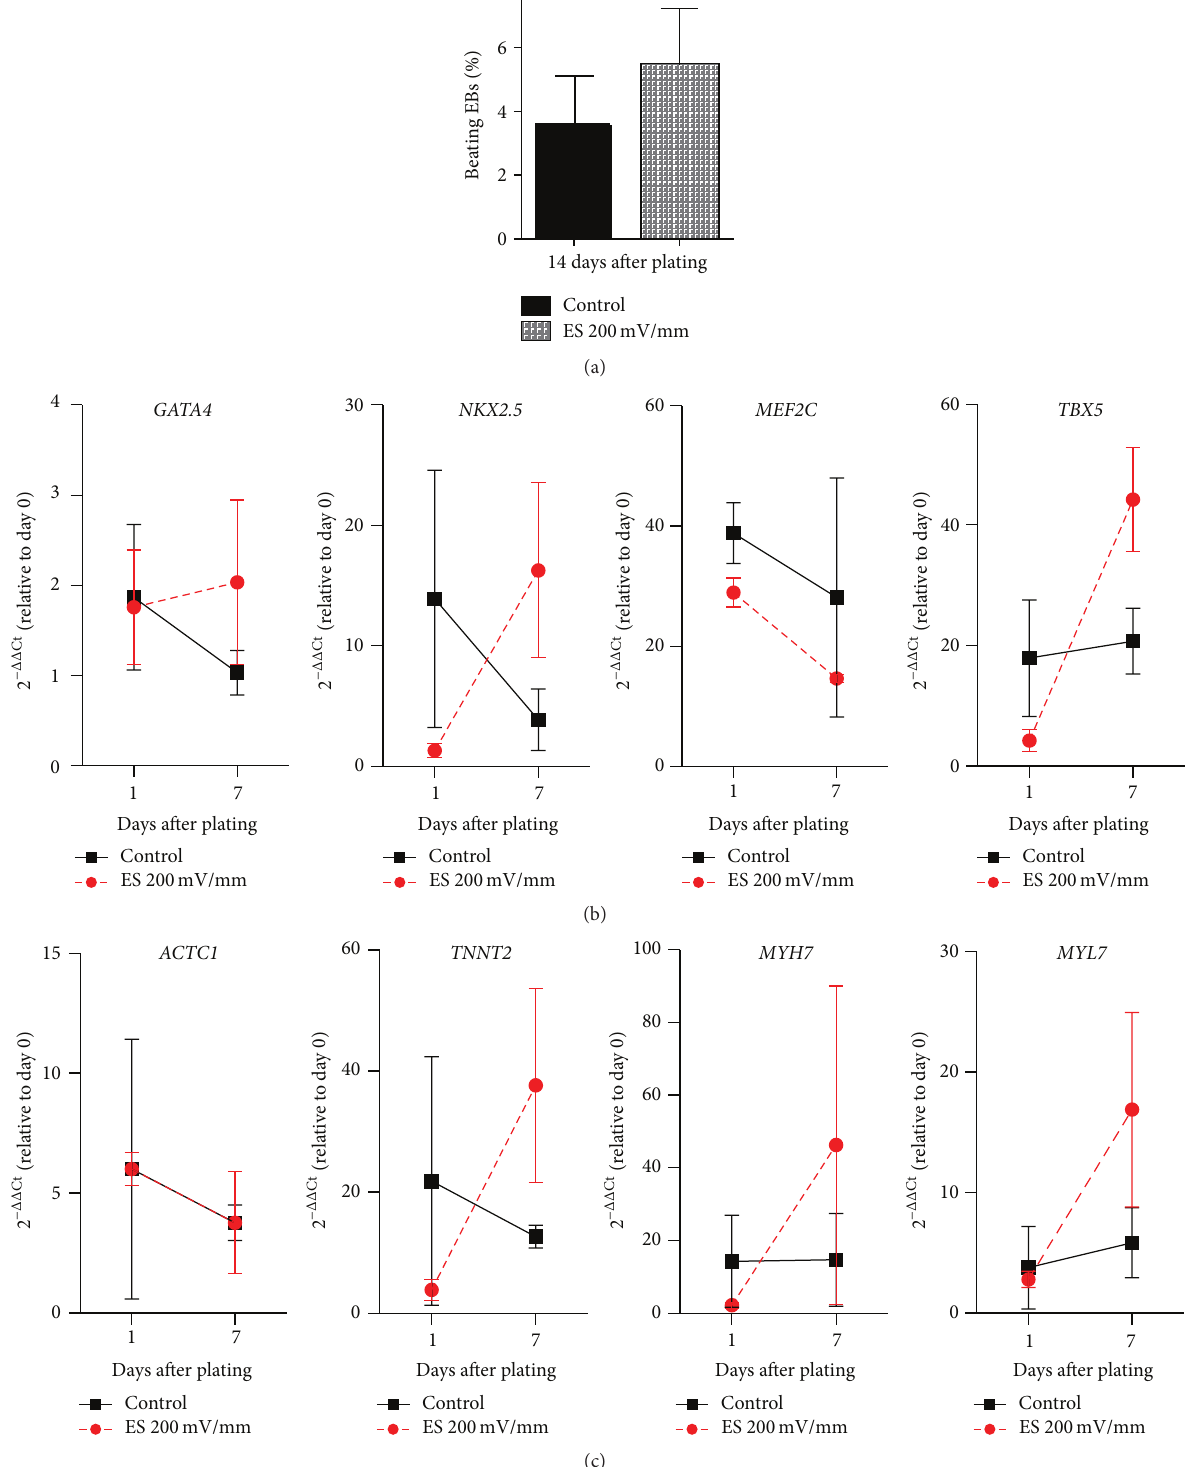
Figure 4: Acute electrical stimulation did not promote cardiac differentiation of CERA007c6 iPSCs. (a) The effect of acute electrical stimulation at 200 mV/mm for 5 min on cardiac differentiation of CERA007c6 iPSCs at day 14 after plating ( 𝑛 = 3 independent experiments). (b-c) Quantitative RT-PCR analysis for the expression of cardiac transcription factors (b) and cardiac contractile muscle proteins (c) in electrically stimulated and control EBs at days 0, 1, and 7 after electrical stimulation ( 𝑛 = 3 independent experiments). Data are expressed as mean ±